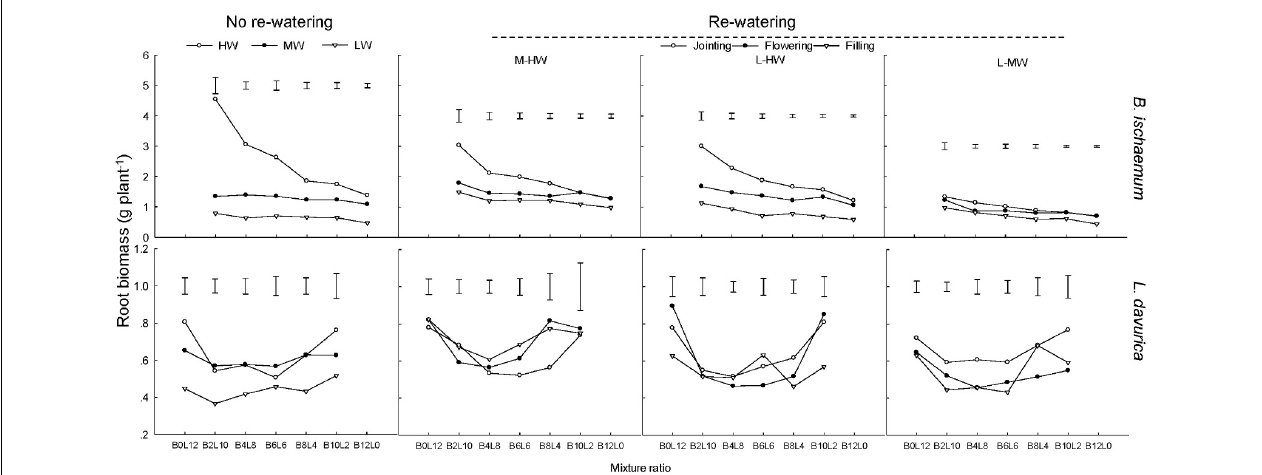
FIGURE 1 | Root biomass (RB) per plant of B. ischaemum (B) and L. davurica (L) at different mixture ratios under each water treatment. HW: 80 ± 5% FC; MW: 60 ± 5% FC; LW: 40 ± 5% FC; M-HW: soil water content increased from MW to HW; L-MW: soil water content increased from LW to MW; L-HW: soil water content increased from LW to HW. The vertical bars indicate the LSD values ( P ≤ 0.05) for the RB difference of each species among rewatering periods at each mixture